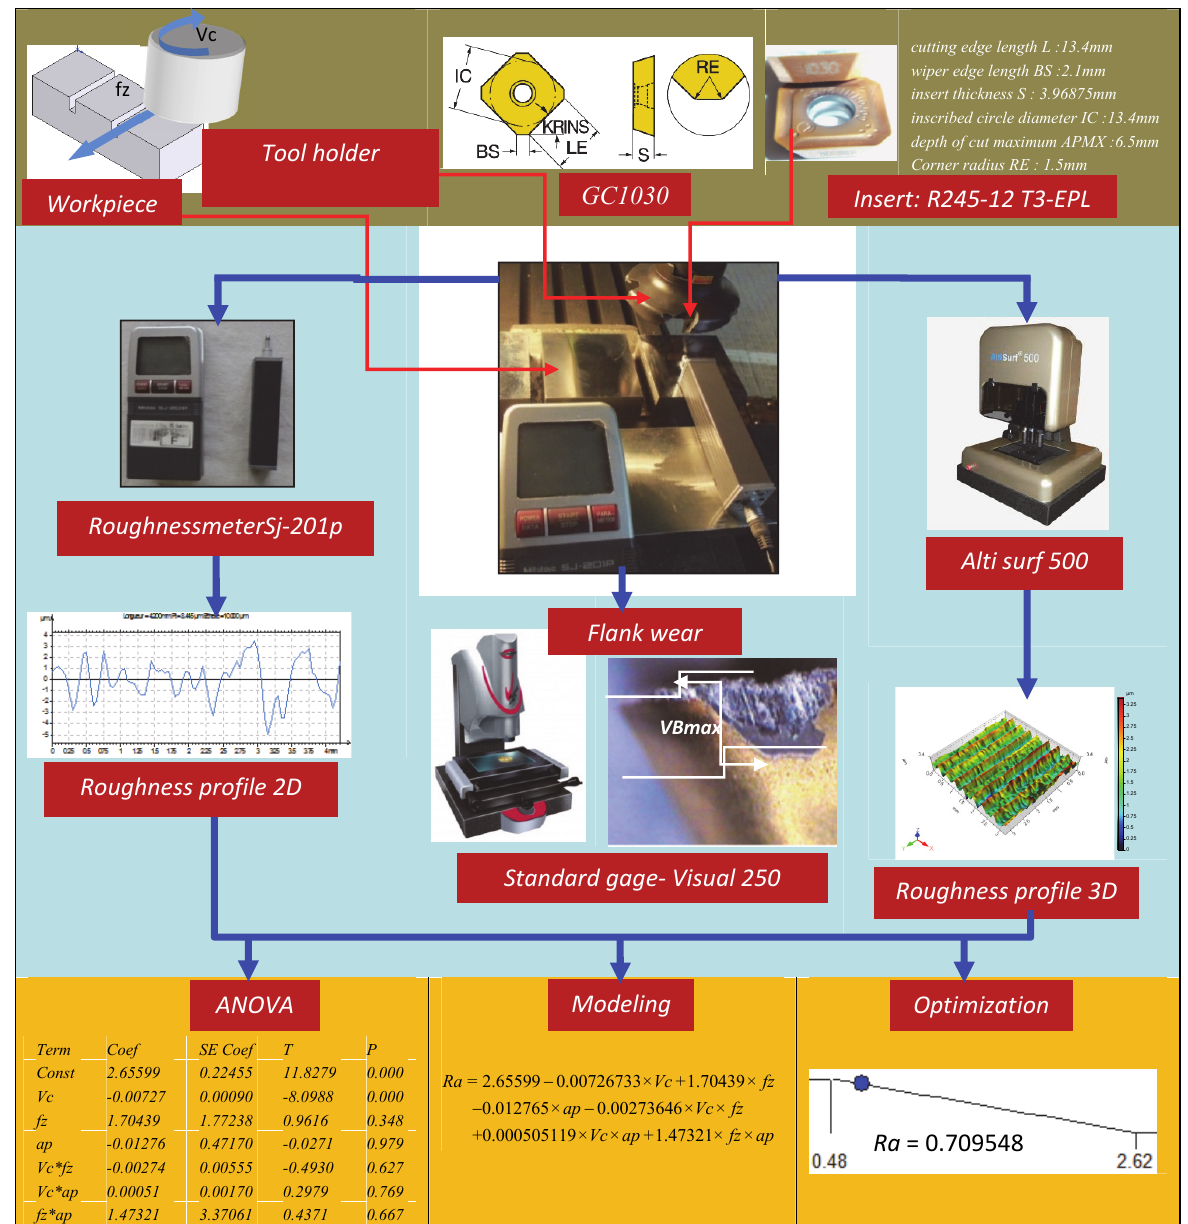
Fig. 1. Illustration of measured surface roughness and tool wear